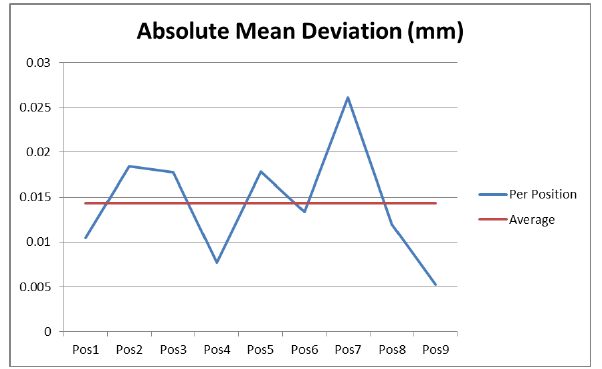
Figure 11. Mean point deviations in mm, direct case